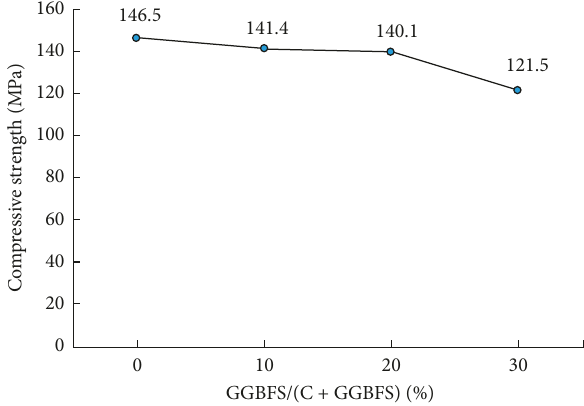
Figure 6: Influence of the content of GGBFS-replaced cement on the slump of UHPFRC.